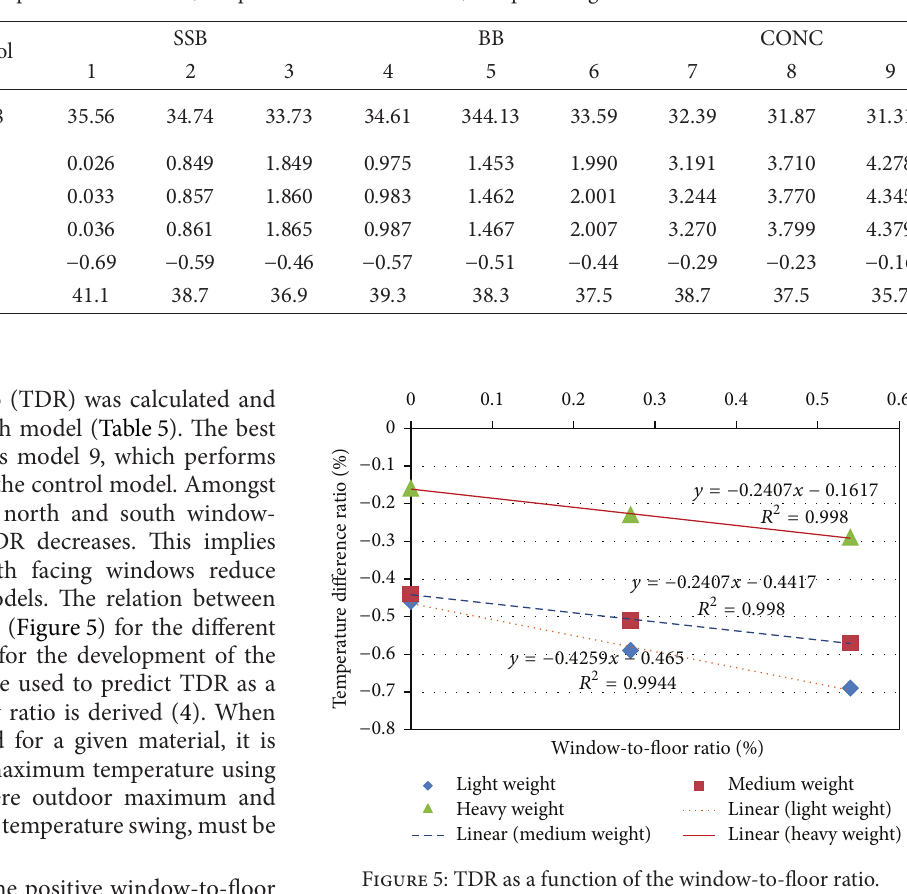
Table 5: Maximum temperature differences, temperature difference ratios, and percentage of overheated hours.